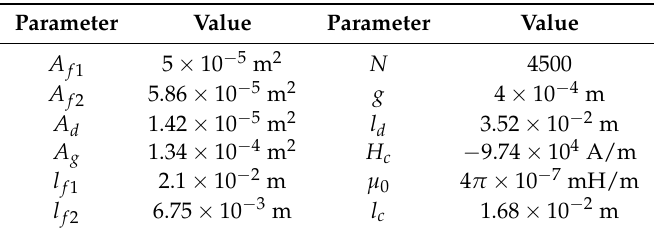
Table 1. Major mathematical parameters for the torque